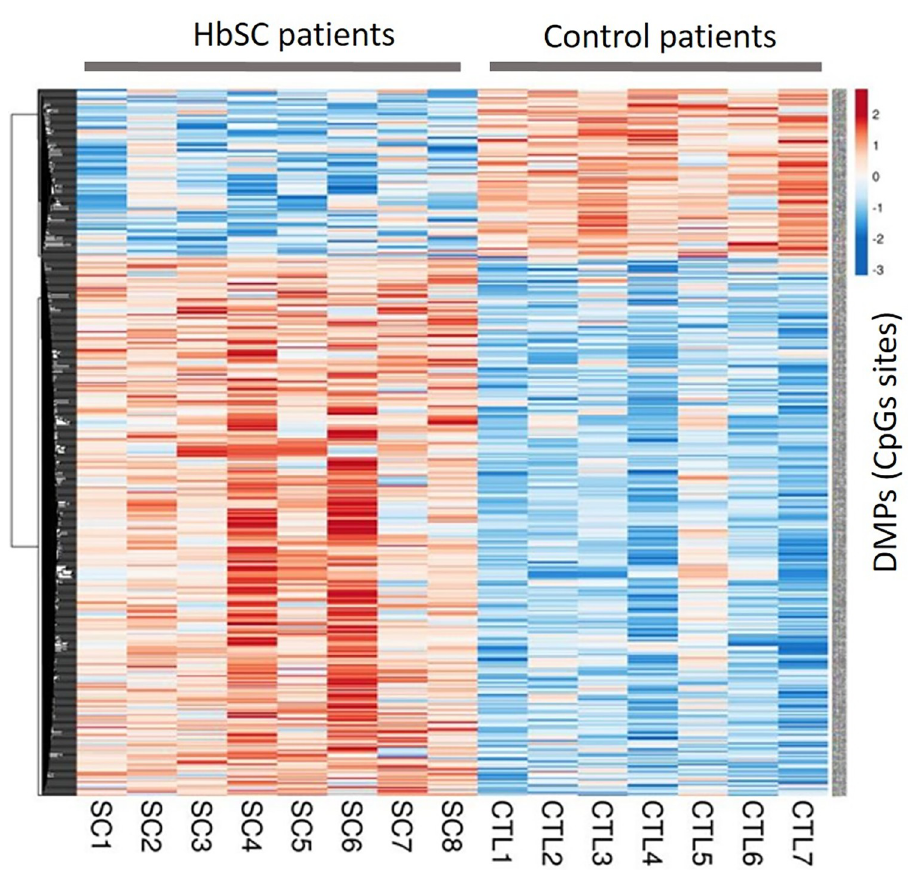
Fig 3. Heatmap generated from the 581 DMPs obtained in the HbSC group compared to the control group. The rows represent each DMP and the columns each patient in the HbSC group and controls (CTL). The colors represent the methylation levels; the more red the more methylated and the more blue the less methylated. From these 581 DMPs, a total of 68 DMPs were in common with those obtained in the HbSS group.